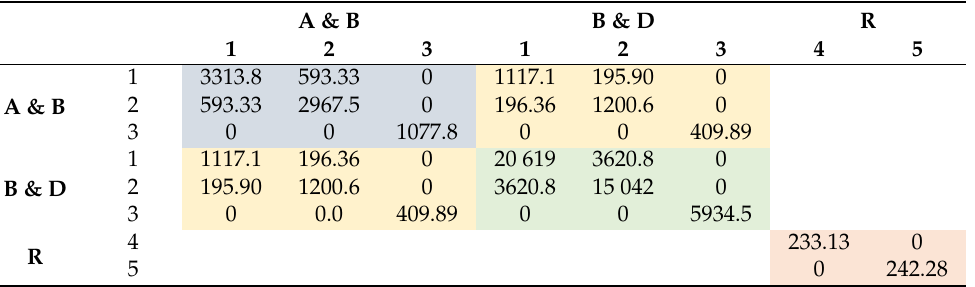
Table 5. Constitutive stiffness matrix A k for the DW model without perforation.